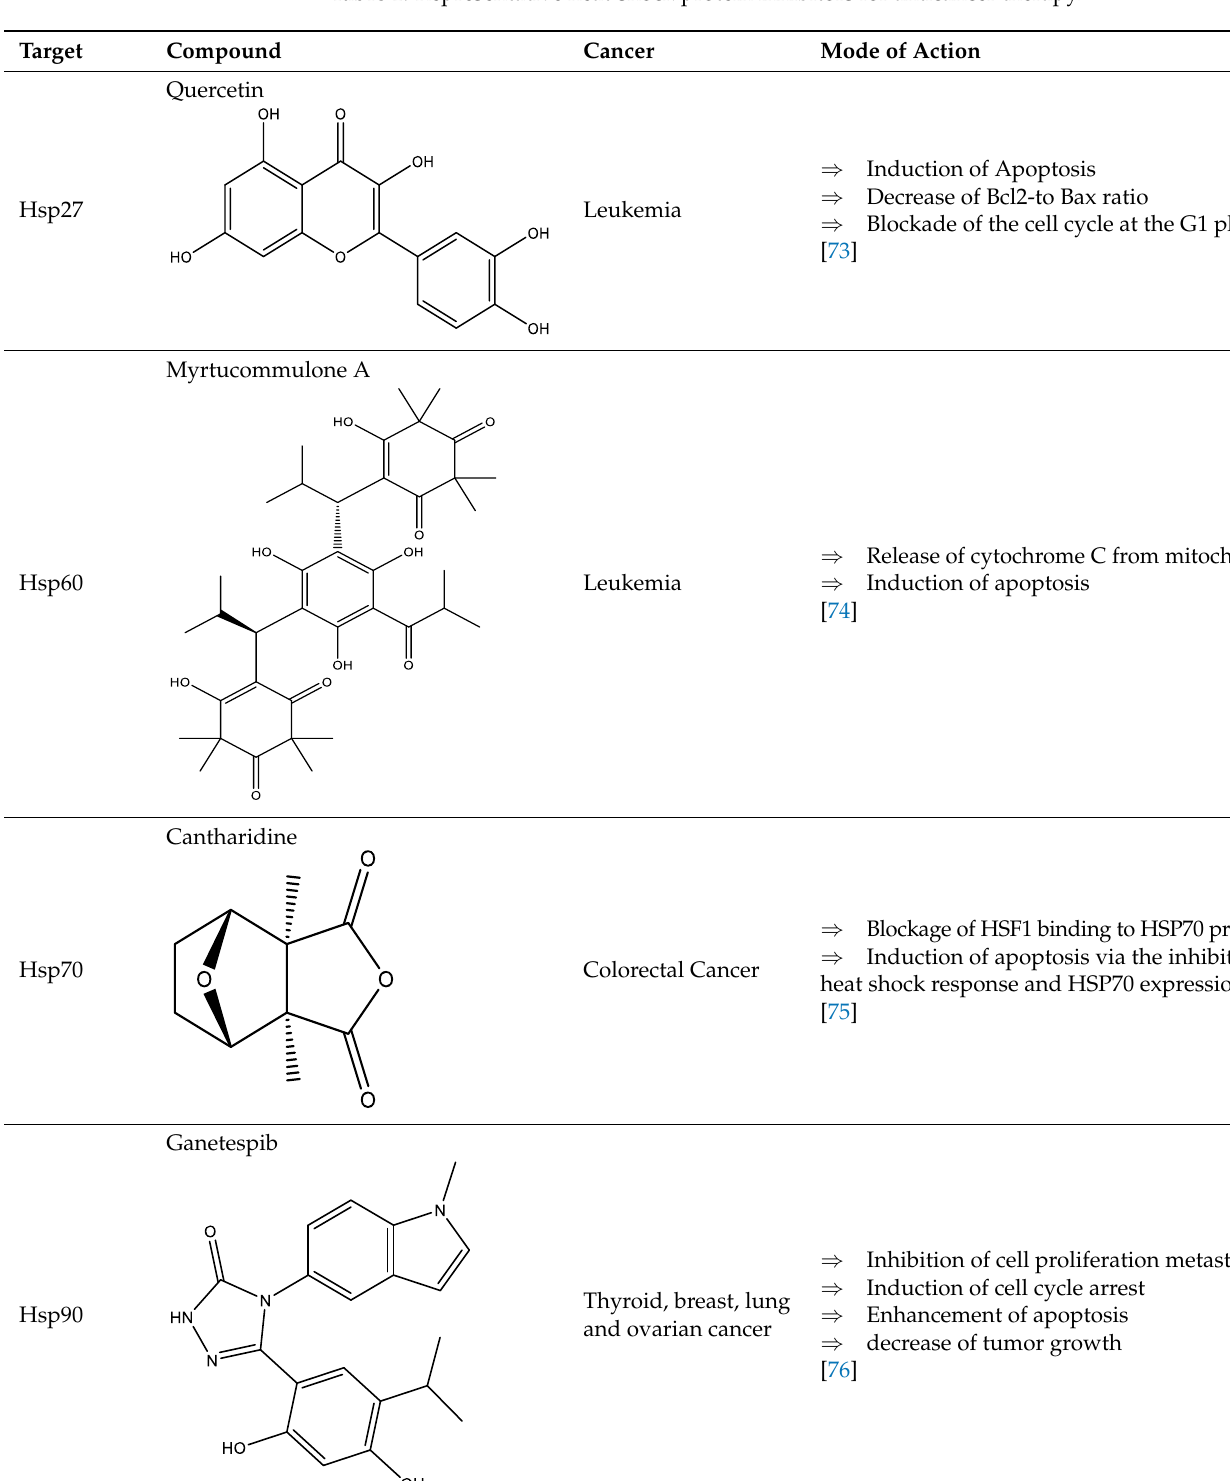
Table 1. Representative heat-shock protein inhibitors for anticancer therapy.